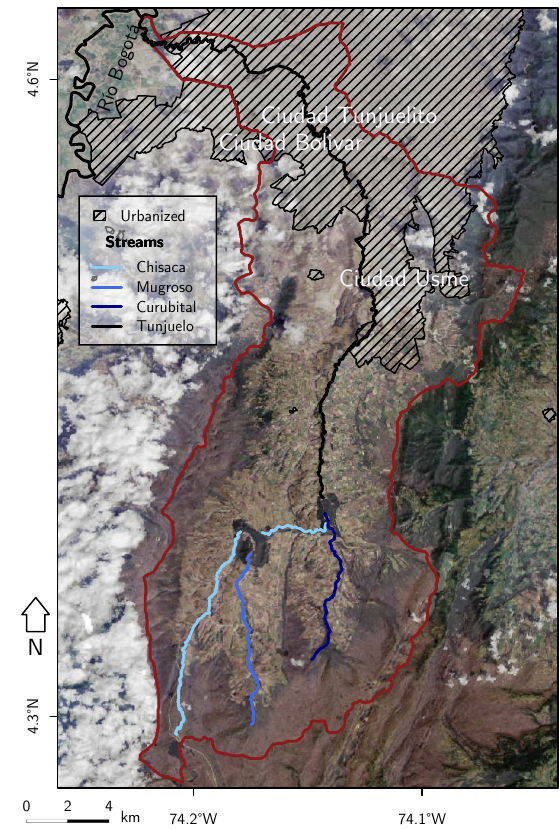
Figure 2. The Rio Tunjuelo drainage basin (data source: Landsat 23 January 2016 Operational Land Imager RGB